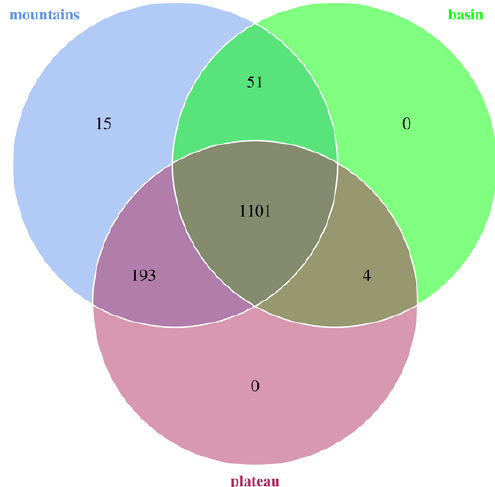
Figure 1. Venn diagrams of the three regions based on OTUs (3% distance). Basin: 14 bacons collected from Suining, Leshan, and Chengdu; mountains: 15 bacons collected from Yibin, Ya’an, and Xichang; plateau: 10 bacons collected from Kangding and Ma’er kang.